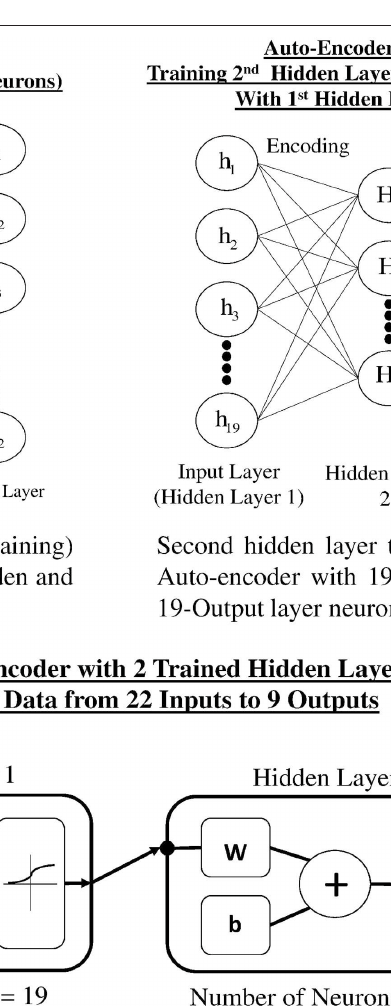
is used for the classification of the test sample. Classification of motor imagery based four human limb movements using NCSA is a four stage process: (1) Selection of combination of neurons in hidden layers; (2) Detector generation and optimization; (3) Selection of best set of the optimized detectors; and (4) Classification of the test data